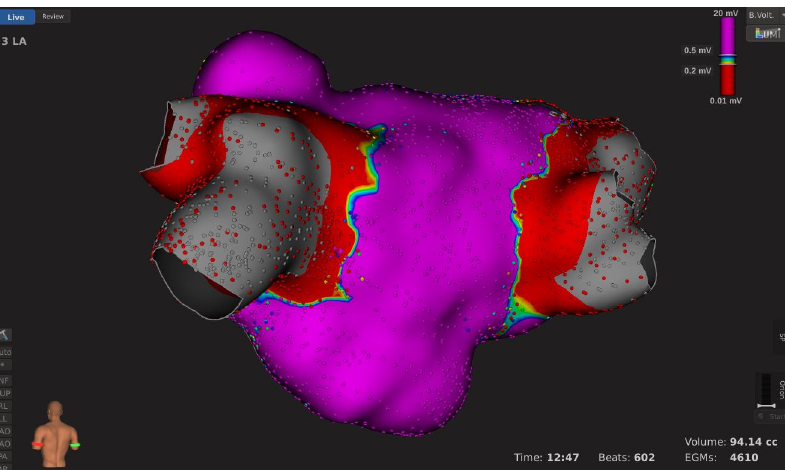
Fig 1. Left atrial bipolar voltage map created with Rhythmia electroanatomical mapping system after successful PVI.